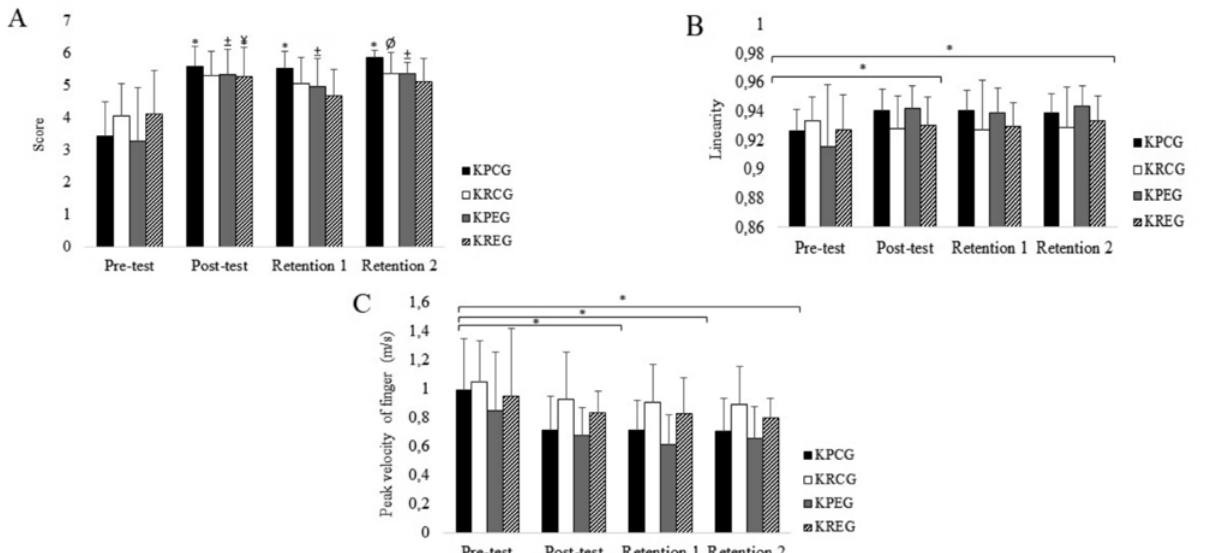
Figure 4A, B, C. KPCG = knowledge of performance control group, KRCG knowledge of results control group, KPEG = knowledge of performance experimental group, KREG = knowledge of results experimental group. Figure 4A= * = difference in the periods factor in relation to the pre-test KPCG, Ø = periods difference in relation to the pre-test KRCG, ± = periods difference in relation to the pre-test KPEG, ¥ = periods difference in relation to the pre-test KREG. Figure 4B, C= * = significant difference